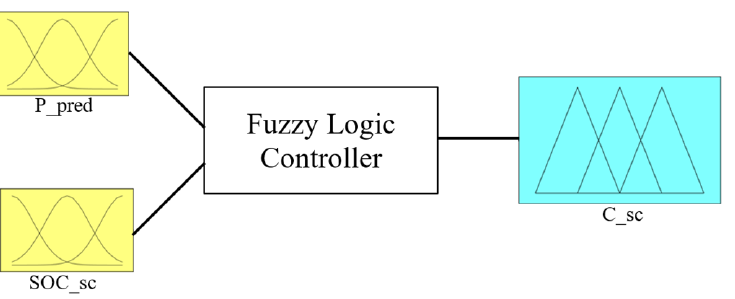
Figure 5. Fuzzy logic controller model.